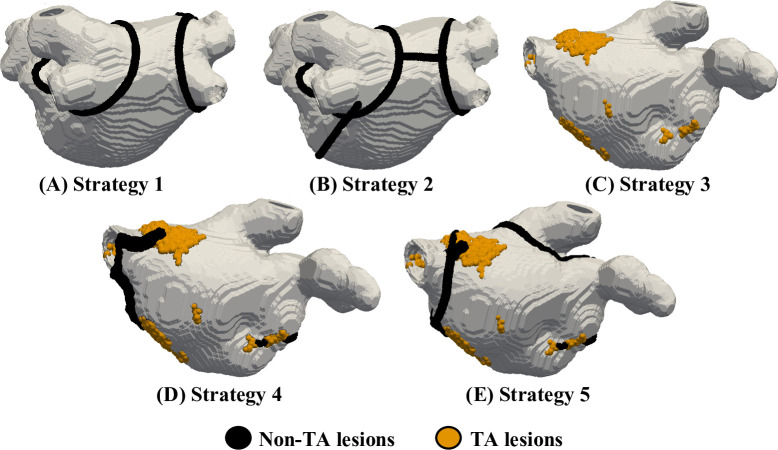
CA strategies tested using virtual ablation platform.(A) Strategy 1: Circumferential PVI, (B) Strategy 2: PVI plus additional linear lesions at the LA roof and a line joining the PV to the MV, (C) Strategy 3: ablation on the TAs, (D) Strategy 4: TA guided ablation with additional linear lesions leading to unexcitable boundaries (PV and MV) and (E) Strategy 5: TA guided ablation with linear lesions (Strategy 4) plus PVI (Strategy 1).